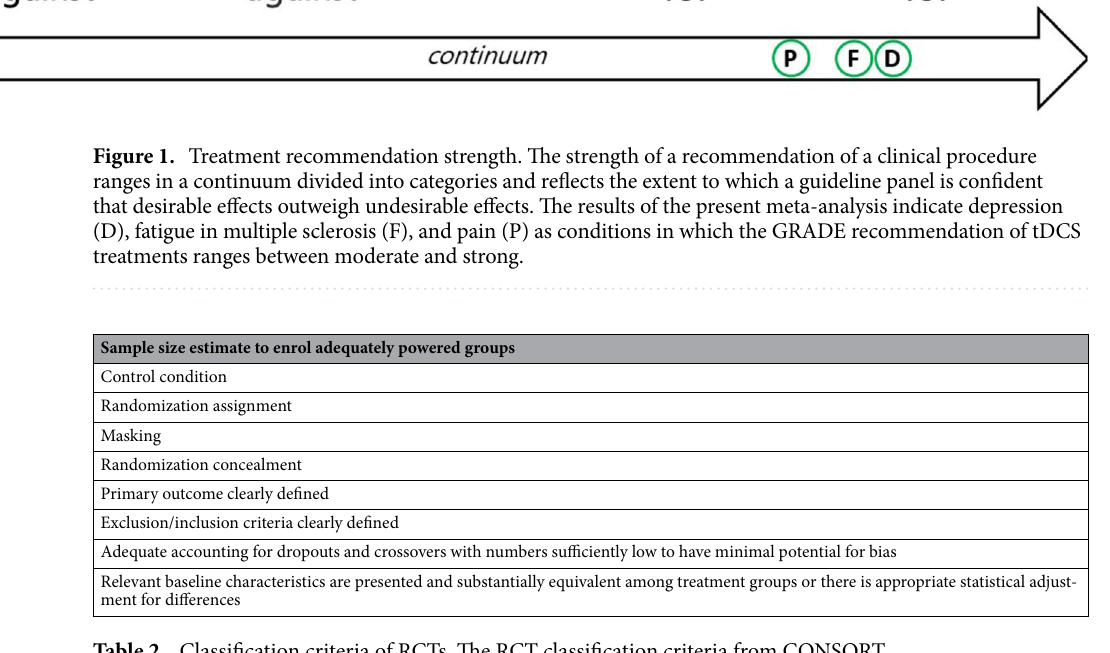
Table 2. Classification criteria of RCTs. The RCT classification criteria from